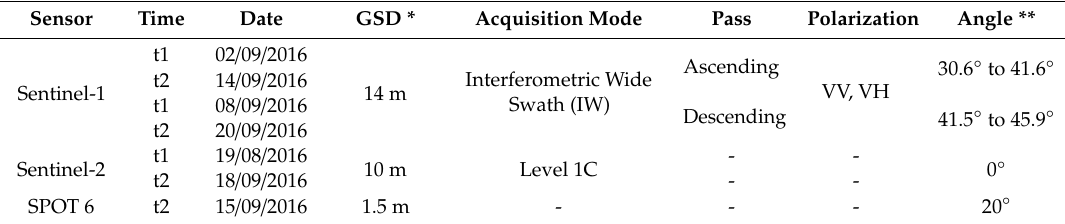
Table 1. The imagery used in the